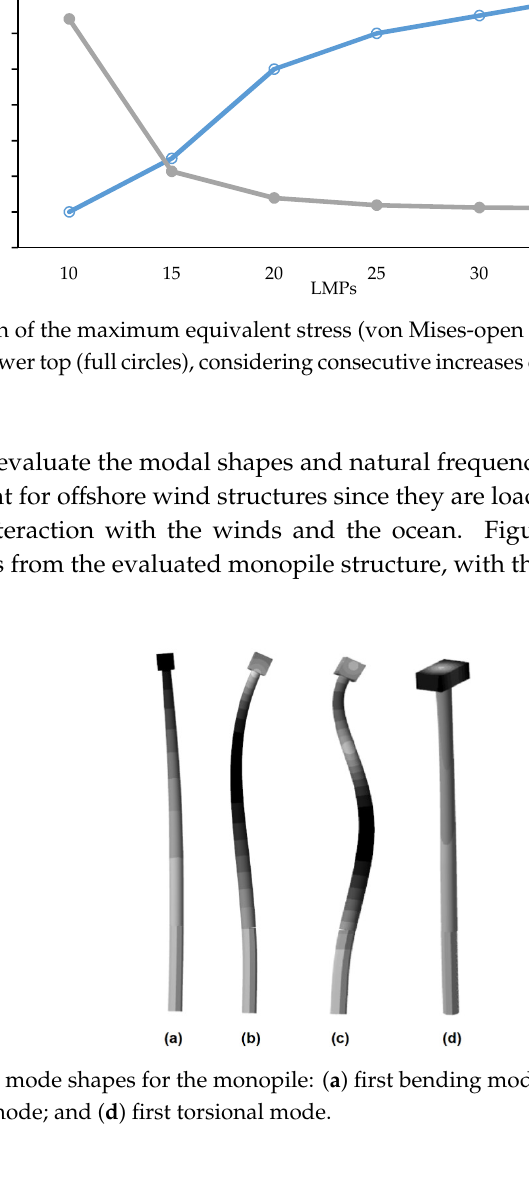
Figure 10. Generic mode shapes for the monopile: ( a ) first bending mode; ( b ) second bending mode; ( c ) third bending mode; and ( d ) first torsional mode.